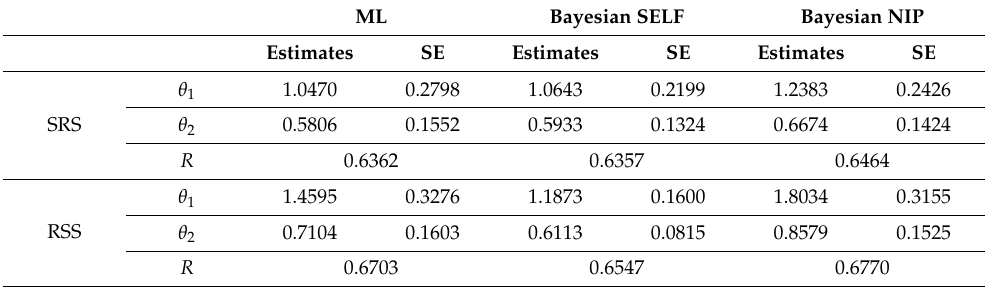
Table 14. ML and Bayesian methods for SRS and RSS for failure times of insulating fluid data.